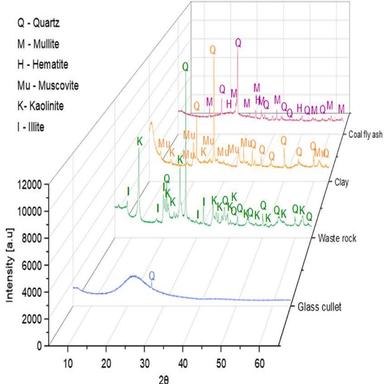
XRD patterns of raw mineral materials used.